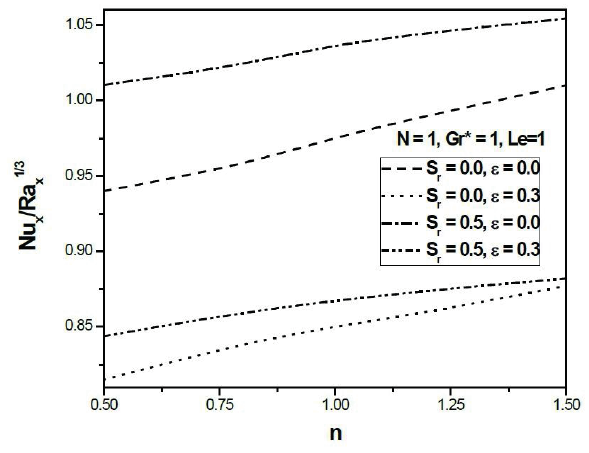
Fig. 4: Variation of heat transfer coefficient against n (Aiding Buoy- ancy.